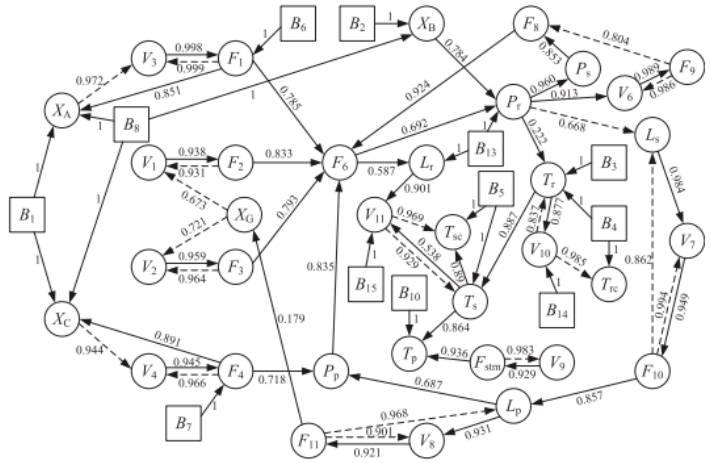
Figure 14. Probabilistic signed digraph of the TE process in Peng Di’s study. Reproduced with permission from [Peng, D.; Gu, X.; Xu, Y.; Zhu, Q.], [Journal of Loss Prevention in the Process Industries]; published by [Elsevier],